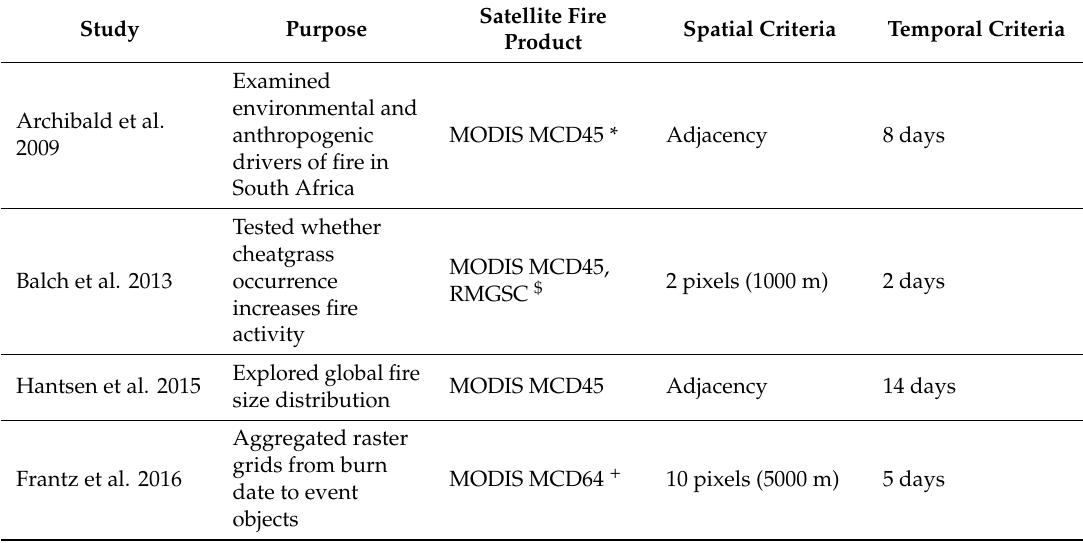
Table 1. Studies using spatio-temporal moving window algorithms for delineating fire